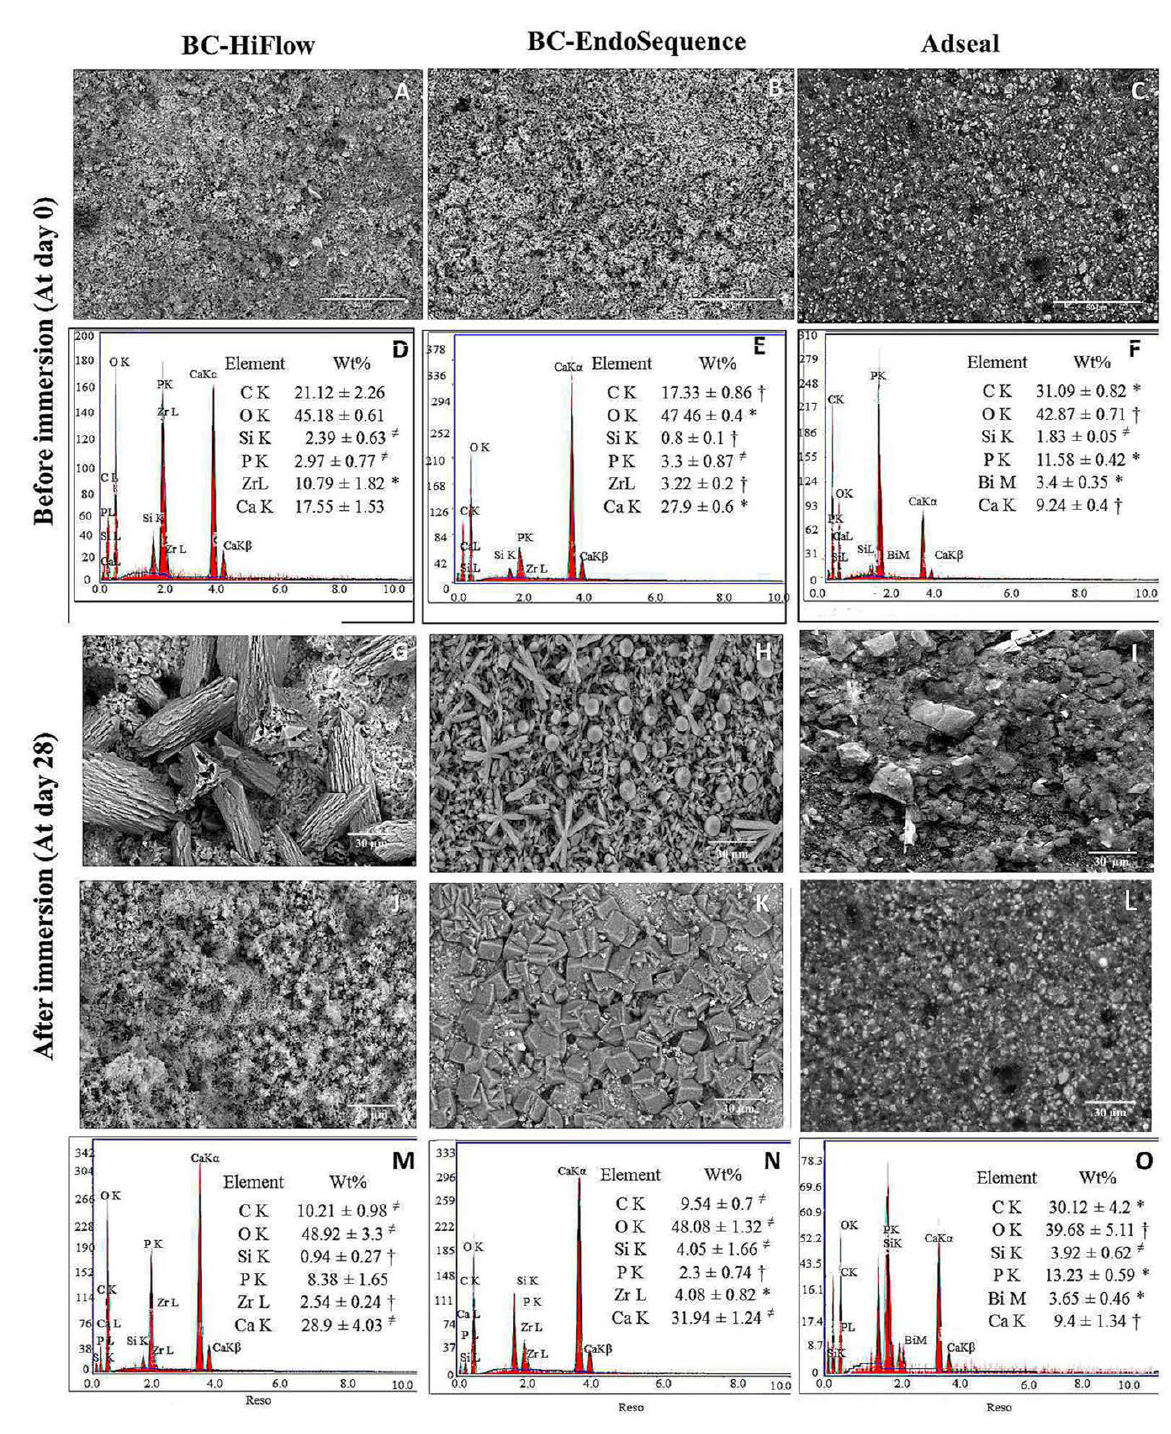
Figure 3. SEM/EDX analysis of the three sealers before ( A – F ) and after 28 days ( G – O ) immersion in water. (*) is the significant greatest value while (†) is the significant lowest value at p < 0.001. ( (cid:54) = ) indicates there is no significant difference between sealers with the same symbol at p >